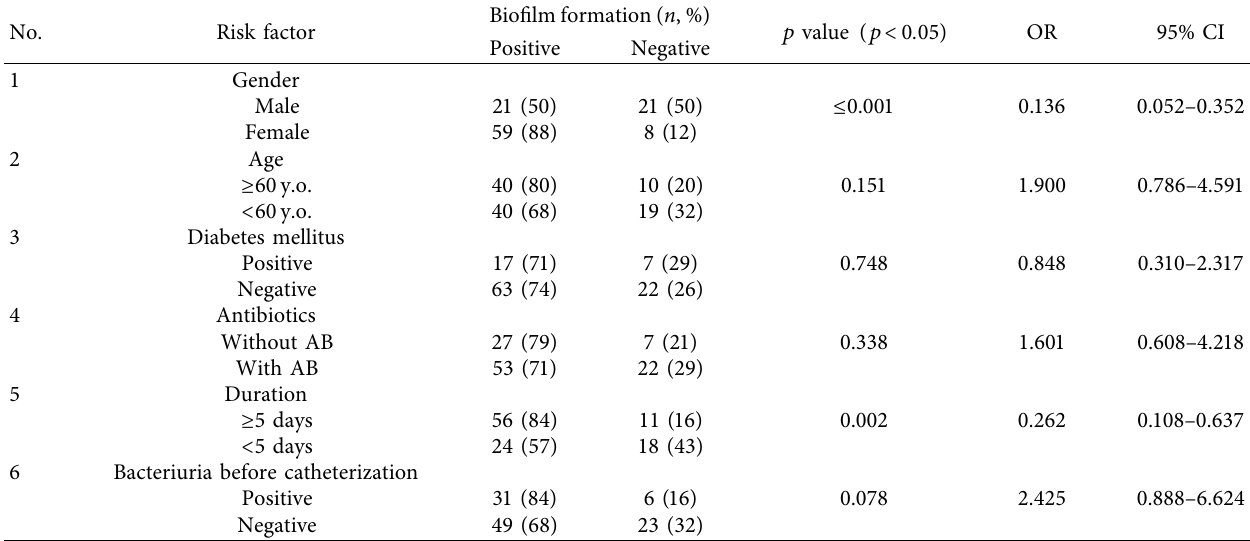
Table 5: Risk factor distribution.